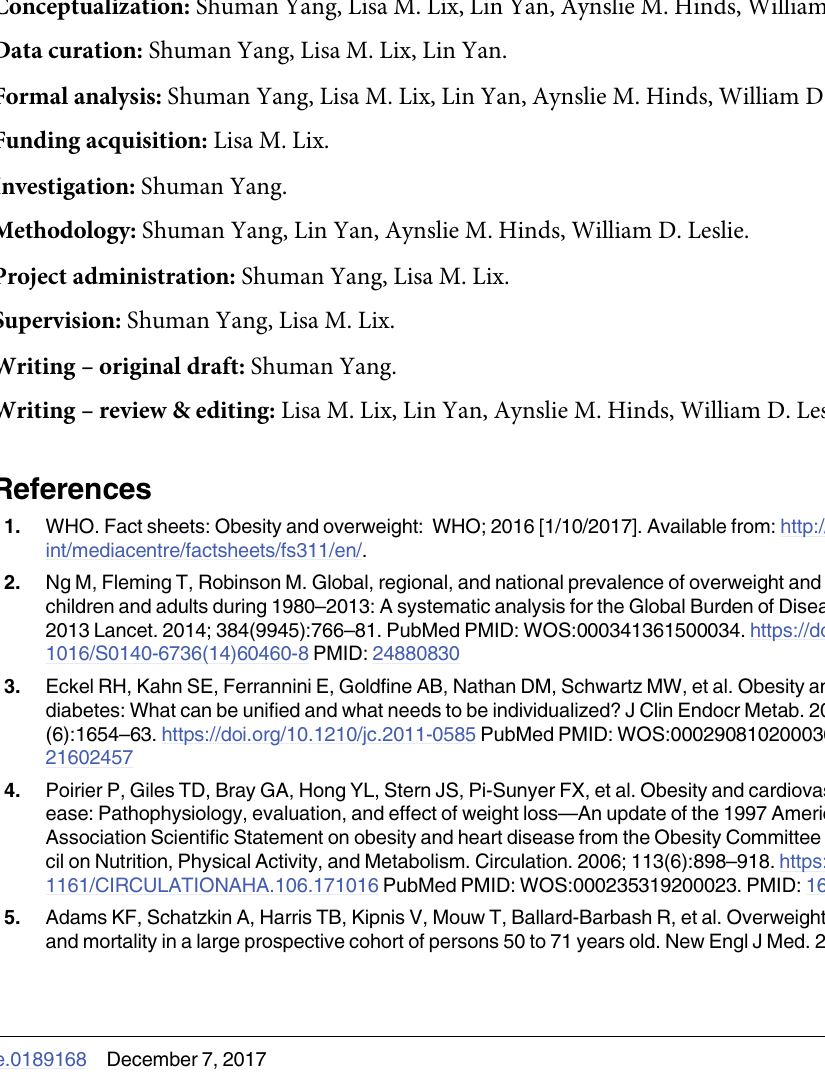
S2 Table. Hazard ratios (HRs) and 95% confidence intervals (95% CIs) for the association of each major osteoporotic fracture (MOF) site with ICD-coded obesity and measured obe- sity. HRs were adjusted for age, sex, prior fractures, prolonged glucocorticoid use, COPD diag- nosis, alcohol/substance abuse diagnosis, rheumatoid arthritis diagnosis, and income quintiles. Bold-faced values indicate statistical significance at α =